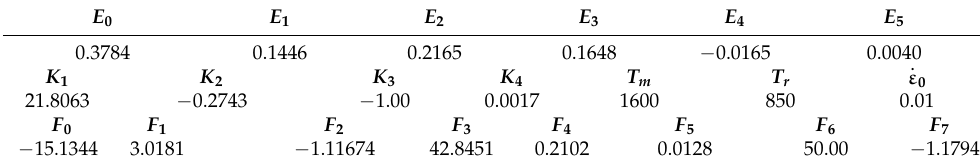
Table 5. The material parameters of TA31 for modified JC model by optimization